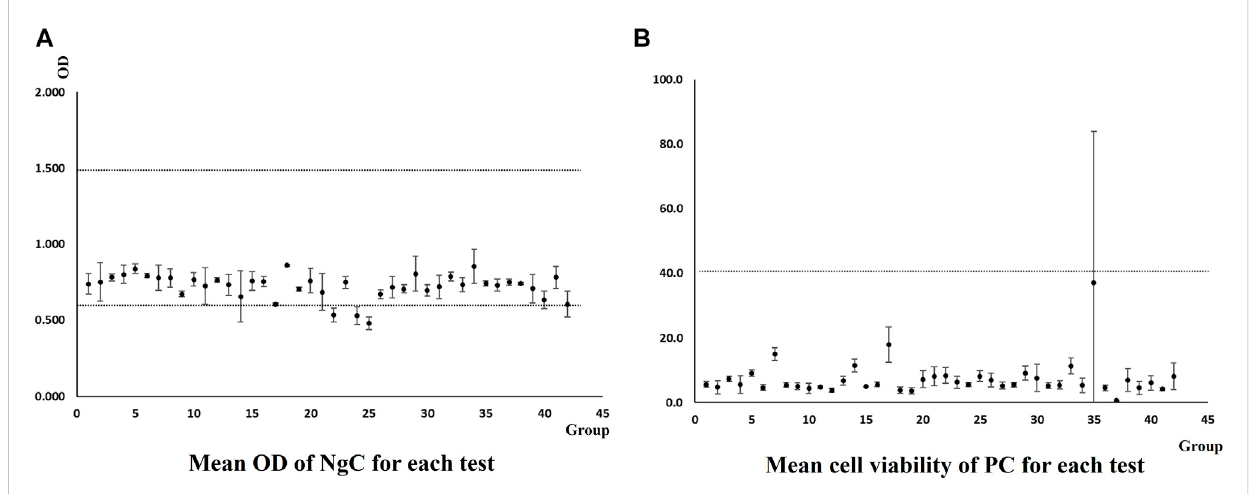
FIGURE 7 Mean OD of NgC and via % of PC generated in the fast-learning class.